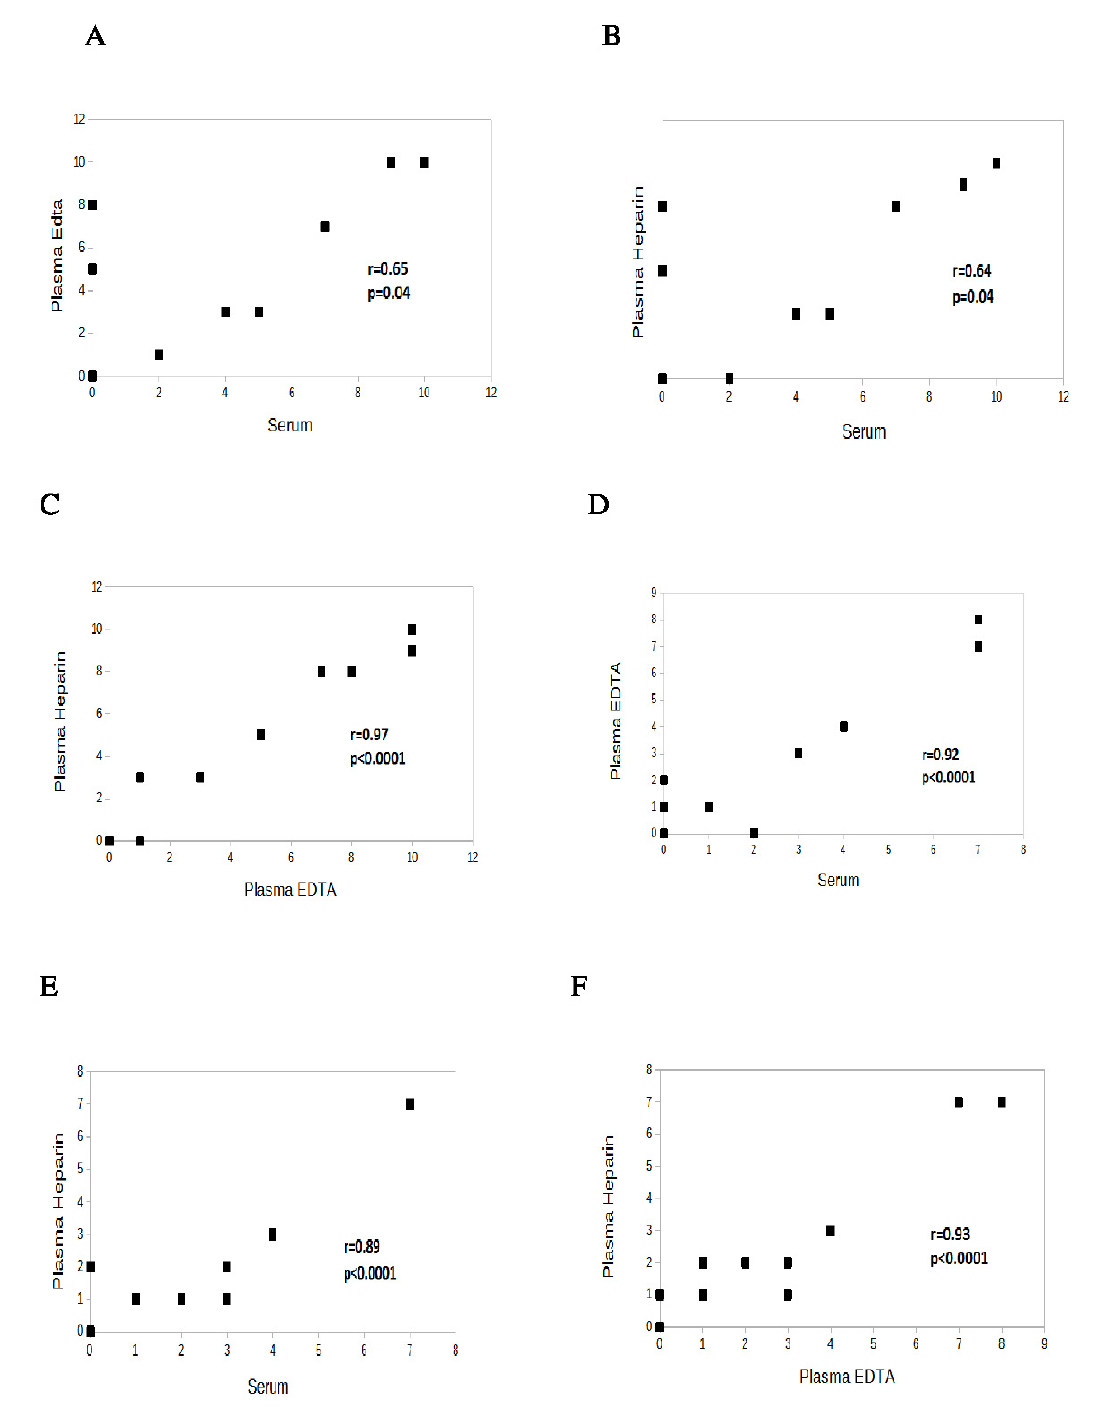
Figure 3. Correlations between serum and plasma levels of anti- Paracoccidioides brasiliensis antibodies determined by double agar gel immunodiffusion test in 27 patients with paracoccidioidomycosis. Correlations observed in (A, B, C) 10 patients before treatment and in (D, E, F) 17 patients under treatment follow-up. Plasma-EDTA: plasma obtained with ethylenediaminetetraacetic acid; plasma-heparin: plasma obtained with heparin. Spearman correlation